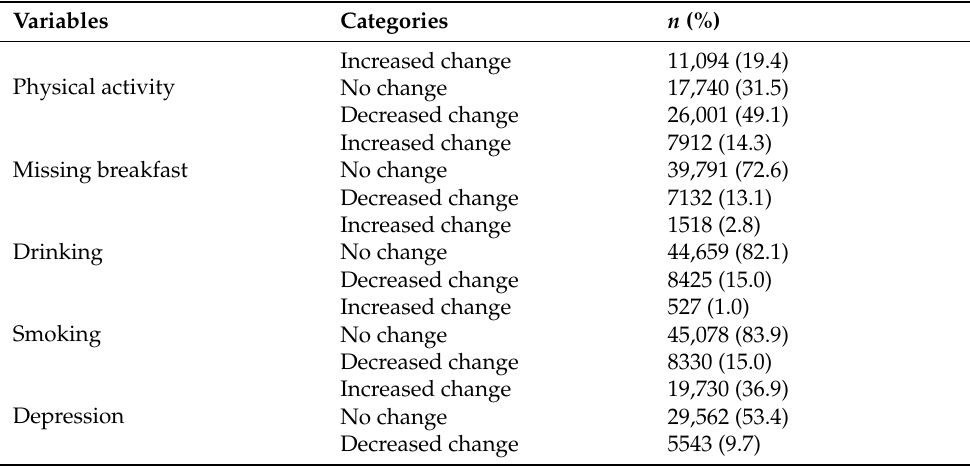
Table 2. Changes in health-related behavior and mental health due to COVID-19 ( n =